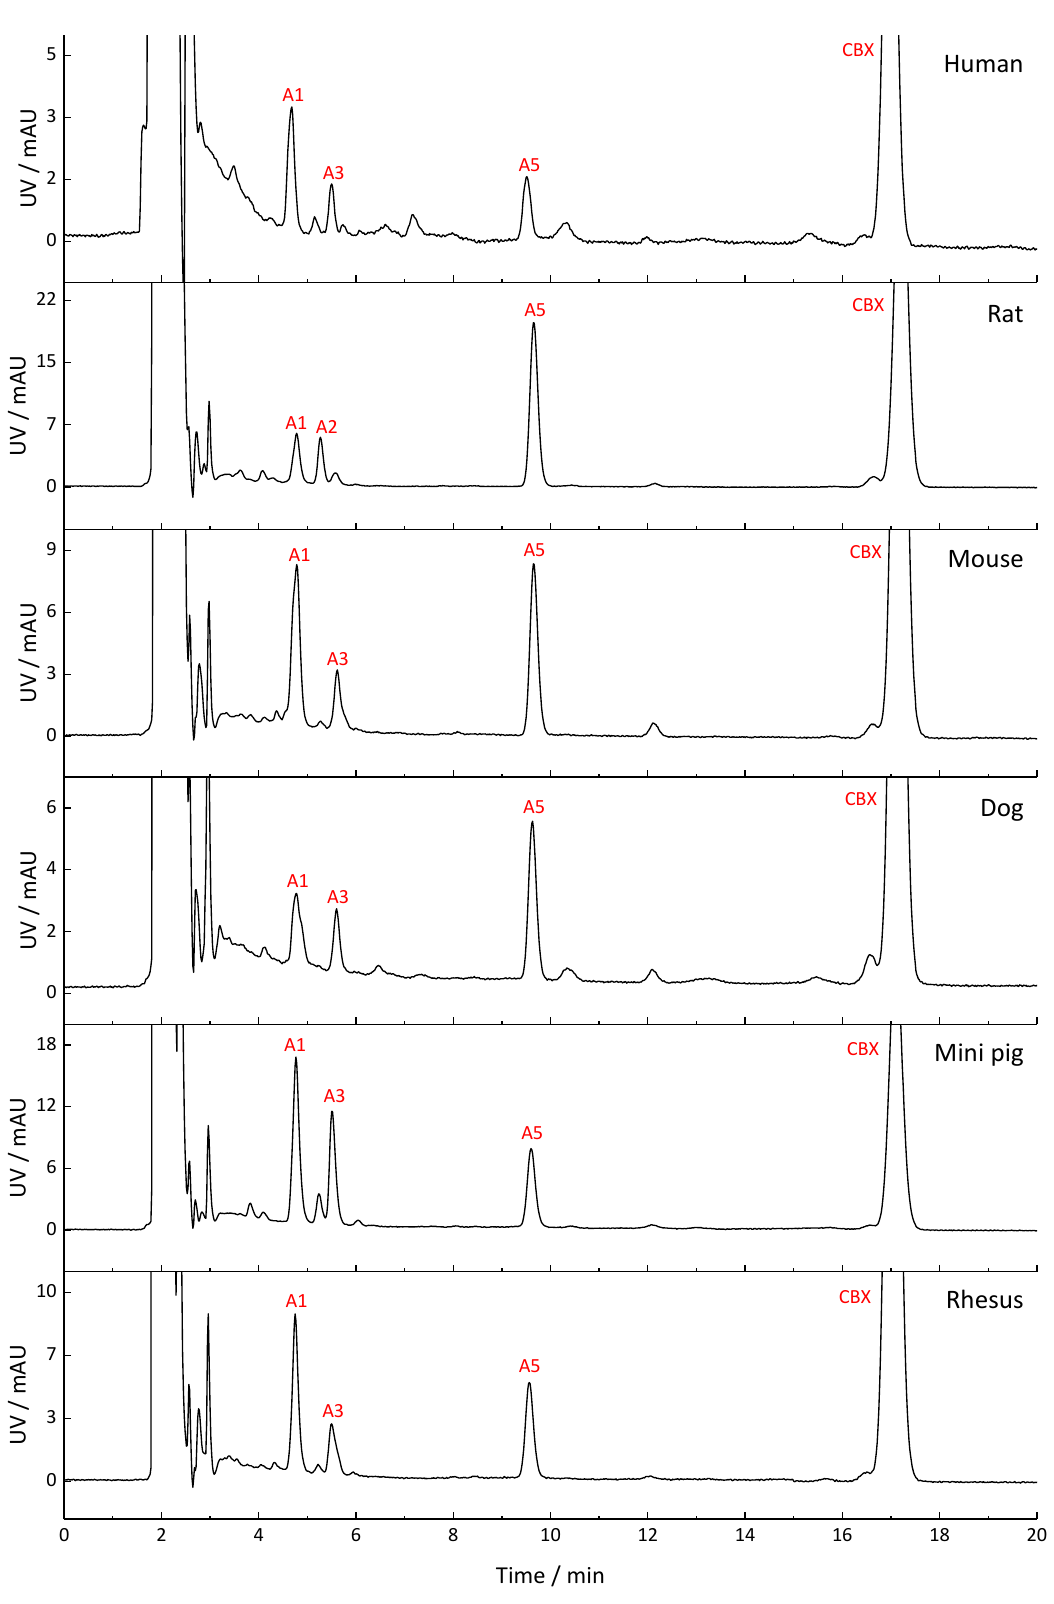
Figure 2. Metabolite profiles of CBX generated in liver microsomes from humans and different animal species. Detection wavelength was 275 nm. In the chromatograms, only metabolite peaks accounting for at least 10% of the total metabolite peak area are labeled. A comprehensive list of the detected metabolites can be found in Table 2.